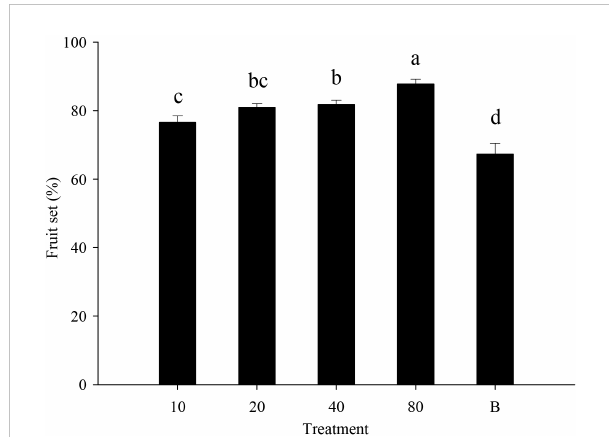
FIGURE 6 Fruit set of strawberry (% per plant) under different experimental treatments during winter 2020-21. Numbers in the X axis refer to the total number of hover fl y adults that were released i.e., 10, 20, 40 or 80 pairs; data are also plotted for a bagging (B) treatment. Different lowercase letters indicate statistically signi fi cant differences between treatment groups (One-way ANOVA, P <0.05, Tukey ’ s HSD post-hoc ).